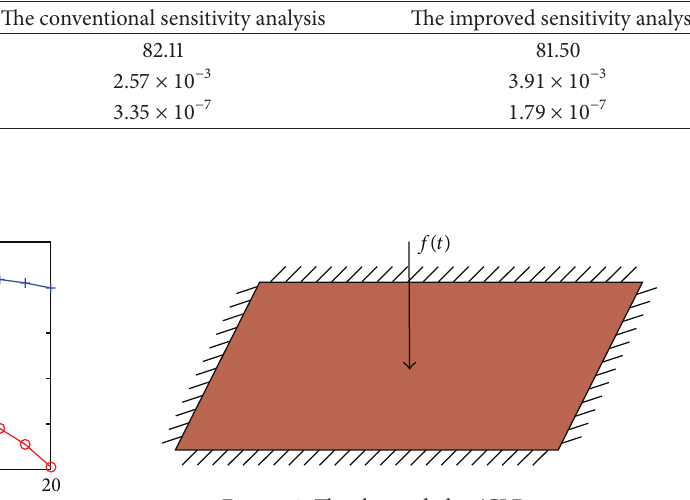
Figure 9: The clamped plate/CLD